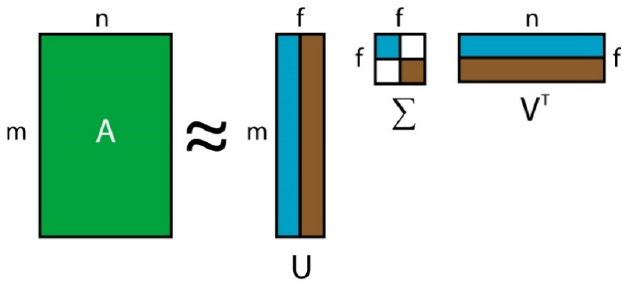
Figure 1. Matrix decomposition using SVD.